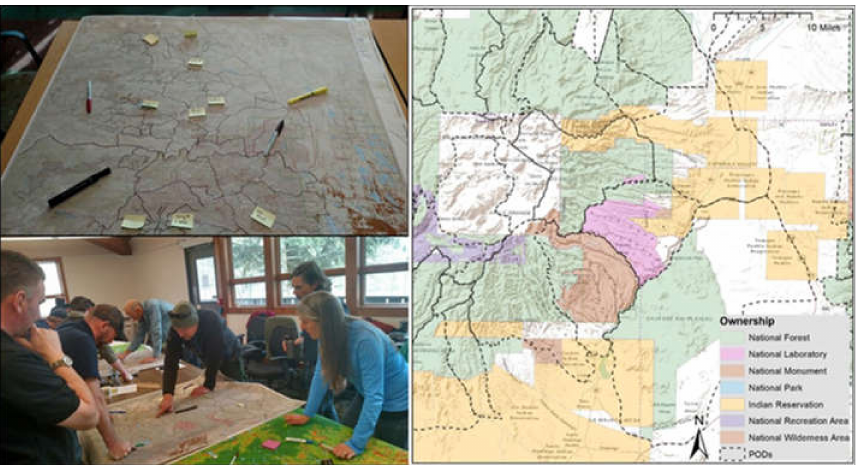
Figure 1. Photos from potential operational delineation (POD) workshops (left), and digitized POD network showing cross-boundary overlap (right). Note that PODs are not a kind of ownership but rather span ownership boundaries. Bottom left photo shows maps of advanced fire behavior analytics provided to support development of